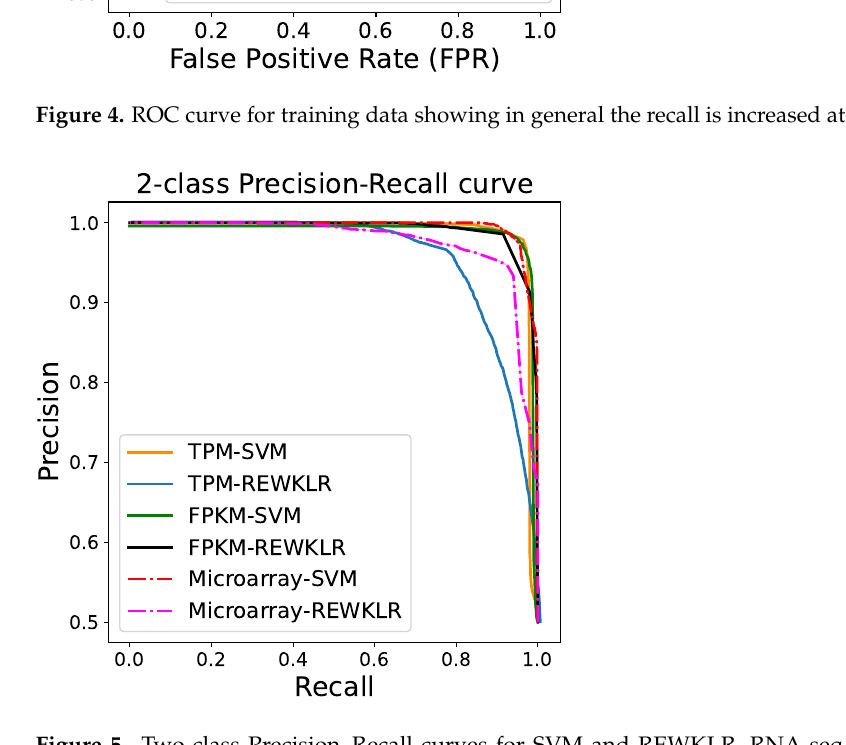
Figure 5. Two-class Precision–Recall curves for SVM and REWKLR. RNA-seq data have better performance in both classifiers in comparison to